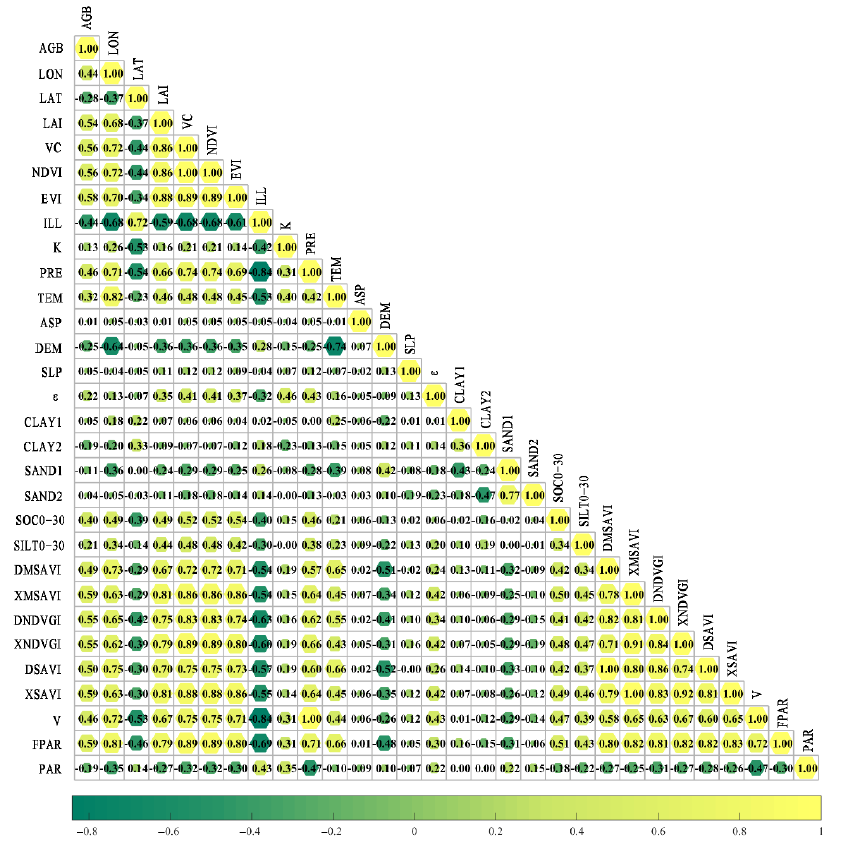
Figure 3. Correlation between AGB and various environmental variables3.1.2. Model accuracy eval- uation.